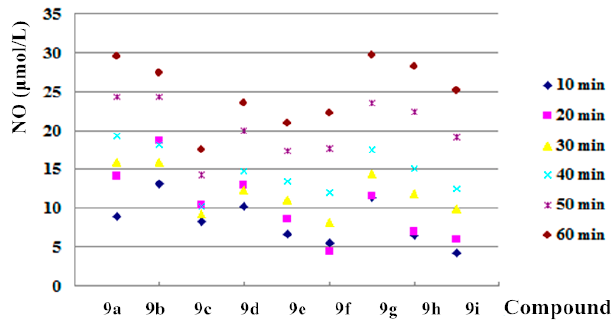
Figure 1. NO-releasing ability of compounds 9a – i .